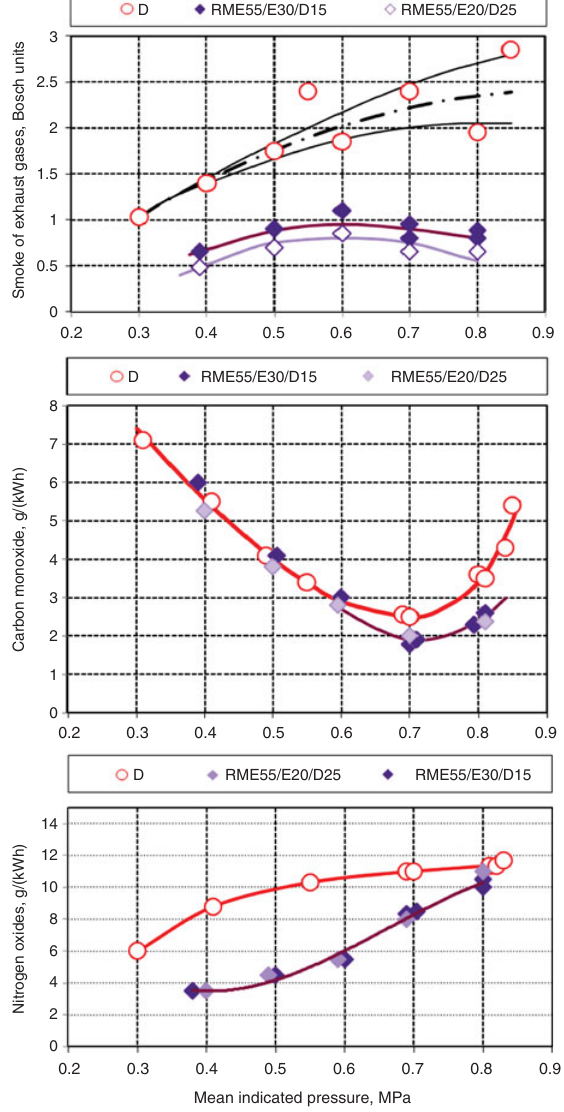
Fig. 4. Change of emission of toxic components in engine EG running on alcohol-containing biodiesels